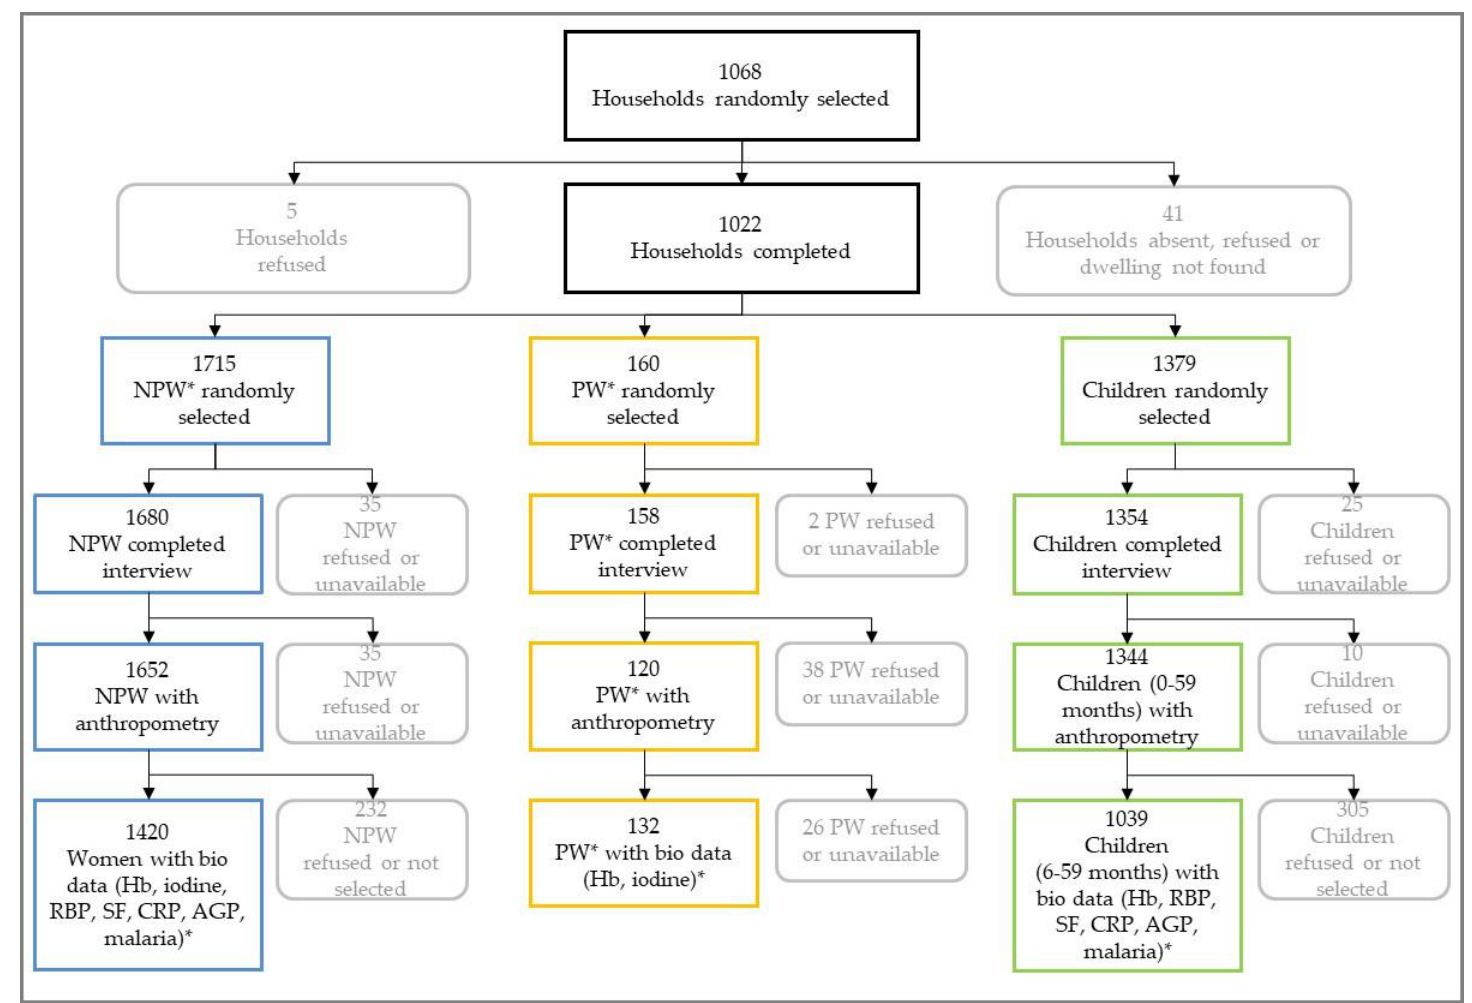
Figure 1. Participation flowchart of households, women and children, Gambian Micronutrient Survey (GMNS 2018). * AGP, alpha-1 acid glycoprotein; CRP, c-reactive protein; Hb, hemoglobin; NPW, non-pregnant women; PW, pregnant women; RBP, retinol binding protein; SF, serum ferrtitin.